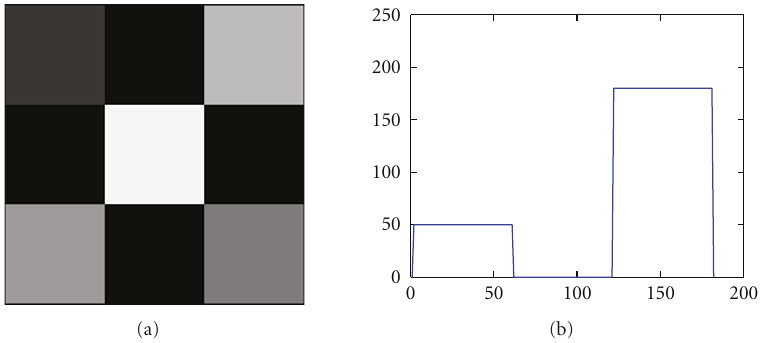
Figure 1: (a) Synthetic image and (b) the grayscale value of the 36th row of (a).